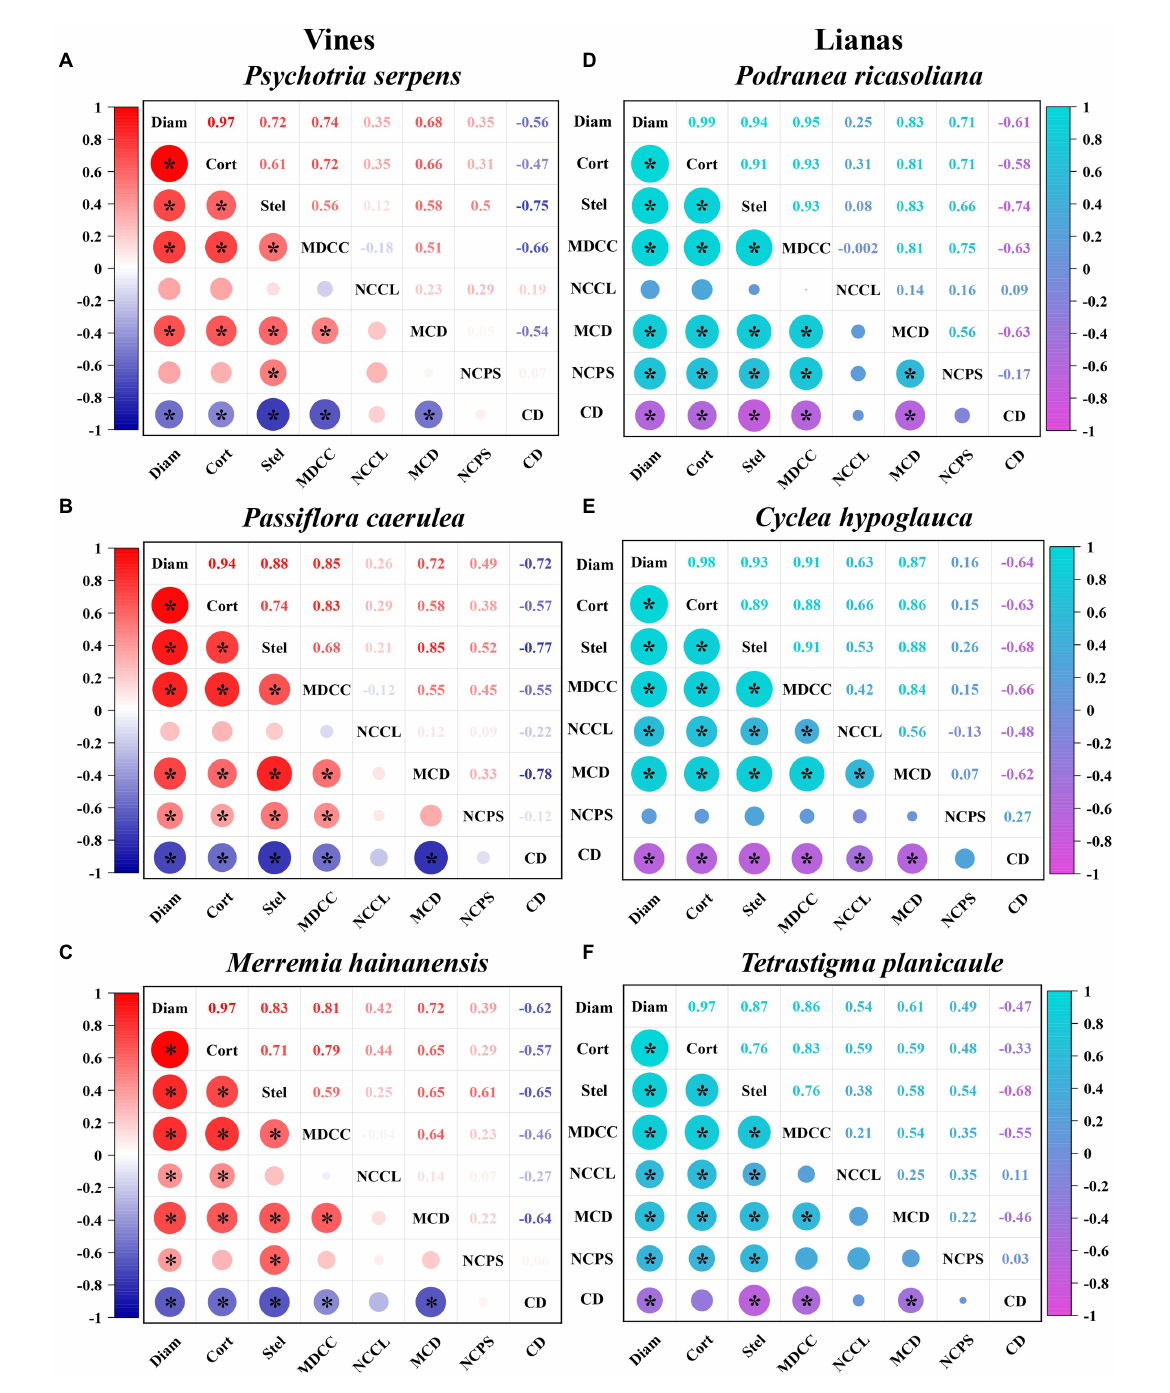
cortical cells of root tips had significant positive correlations with cortex thickness ( r = 0.72–0.93, p < 0.01) and with root tip diameter ( r = 0.74–0.95, p < 0.01; Figure 3) within each species. In contrast,